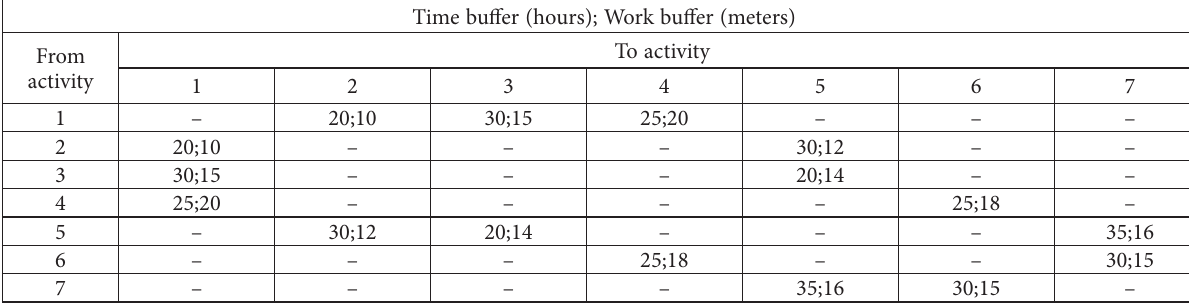
Table 2a. Time and work buffer data – case 1